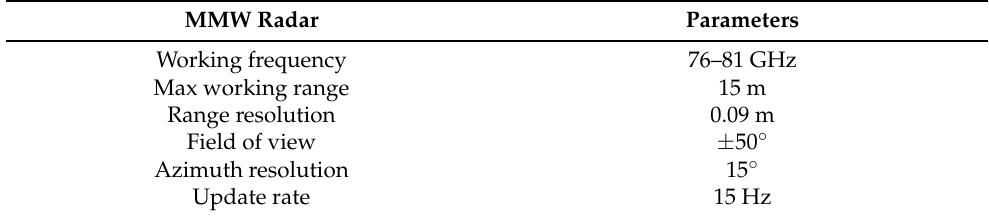
Table 2. Detail specifications of the millimeter wave